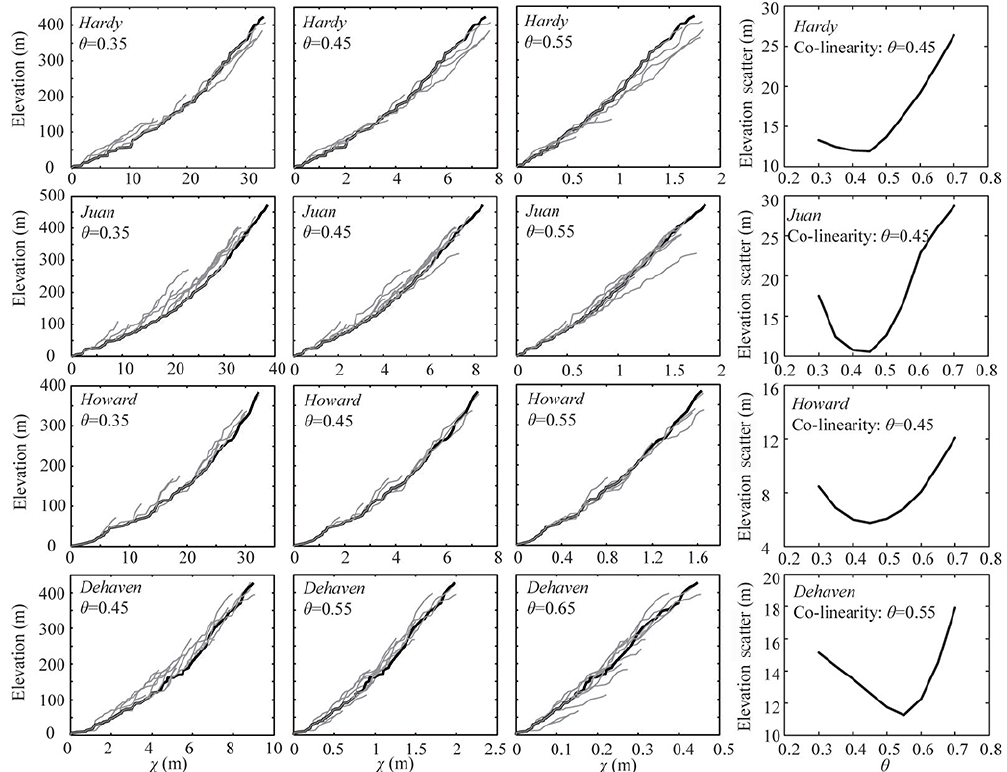
Figure 12. Concavity values that maximize the co-linearity of the main stem with its tributaries. Black thick lines in the χ − z plots are